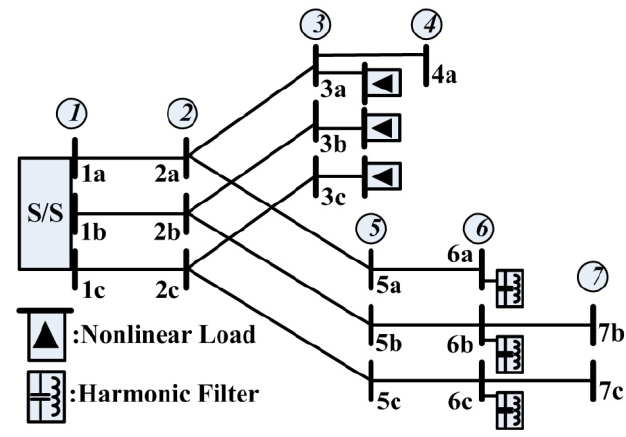
Figure 3. A simple seven-bus test system.